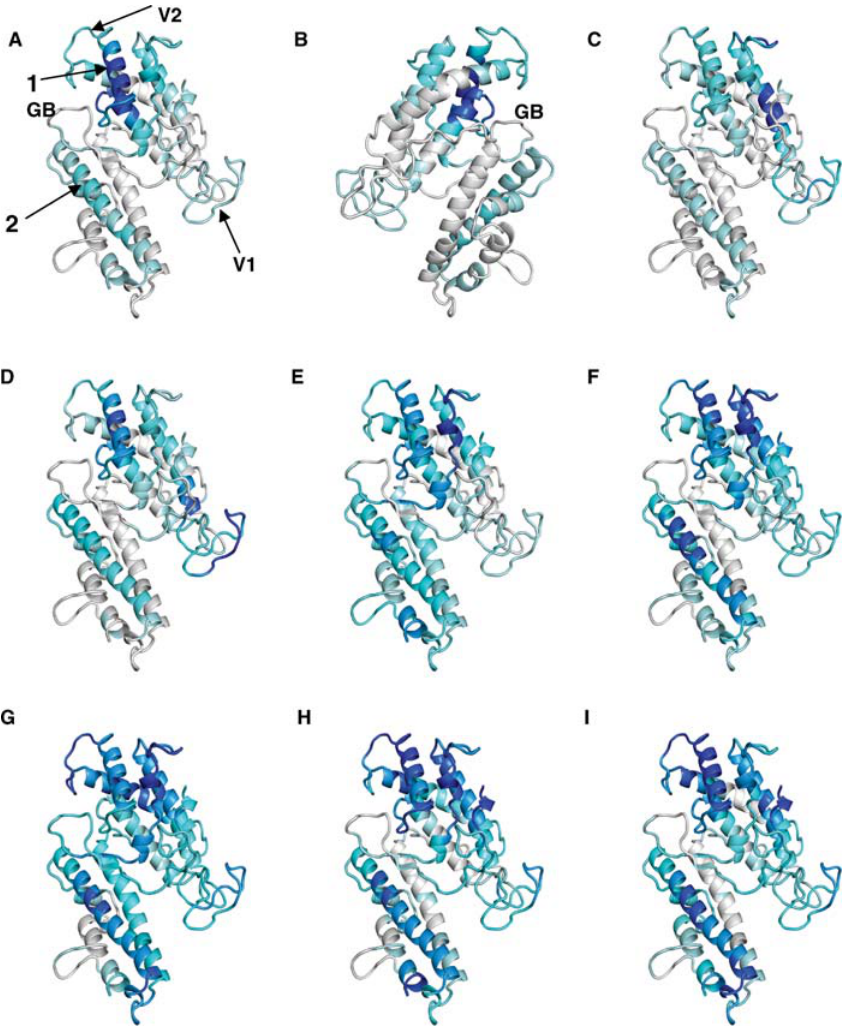
Figure 6. Defining Targets of Antibodies on DBL3X Models of DBL3X in which the intensity of the gray and blue indicates reactivity of plasma tested on a peptide array (PepScan scores). Gray indicates lowest scores and dark blue indicates highest scores. (A and C–I) represent reactivity in eight individual plasma samples. (B) shows the reactivity in the same plasma as tested in (A), but the model has been rotated 180 degrees. Arrow 1 indicates a highly recognized conserved a -helix region, which was not predicted to be an epitope by BepiPred and was characterized by low dN/dS ratios and low sequence variation. Arrow 2 indicates another a -helix with a predicted B cell epitope containing some residues with high sequence variation. Variable regions V1 and V2 are fairly well recognized by most of the serum samples. GB indicates the glycan-binding site of